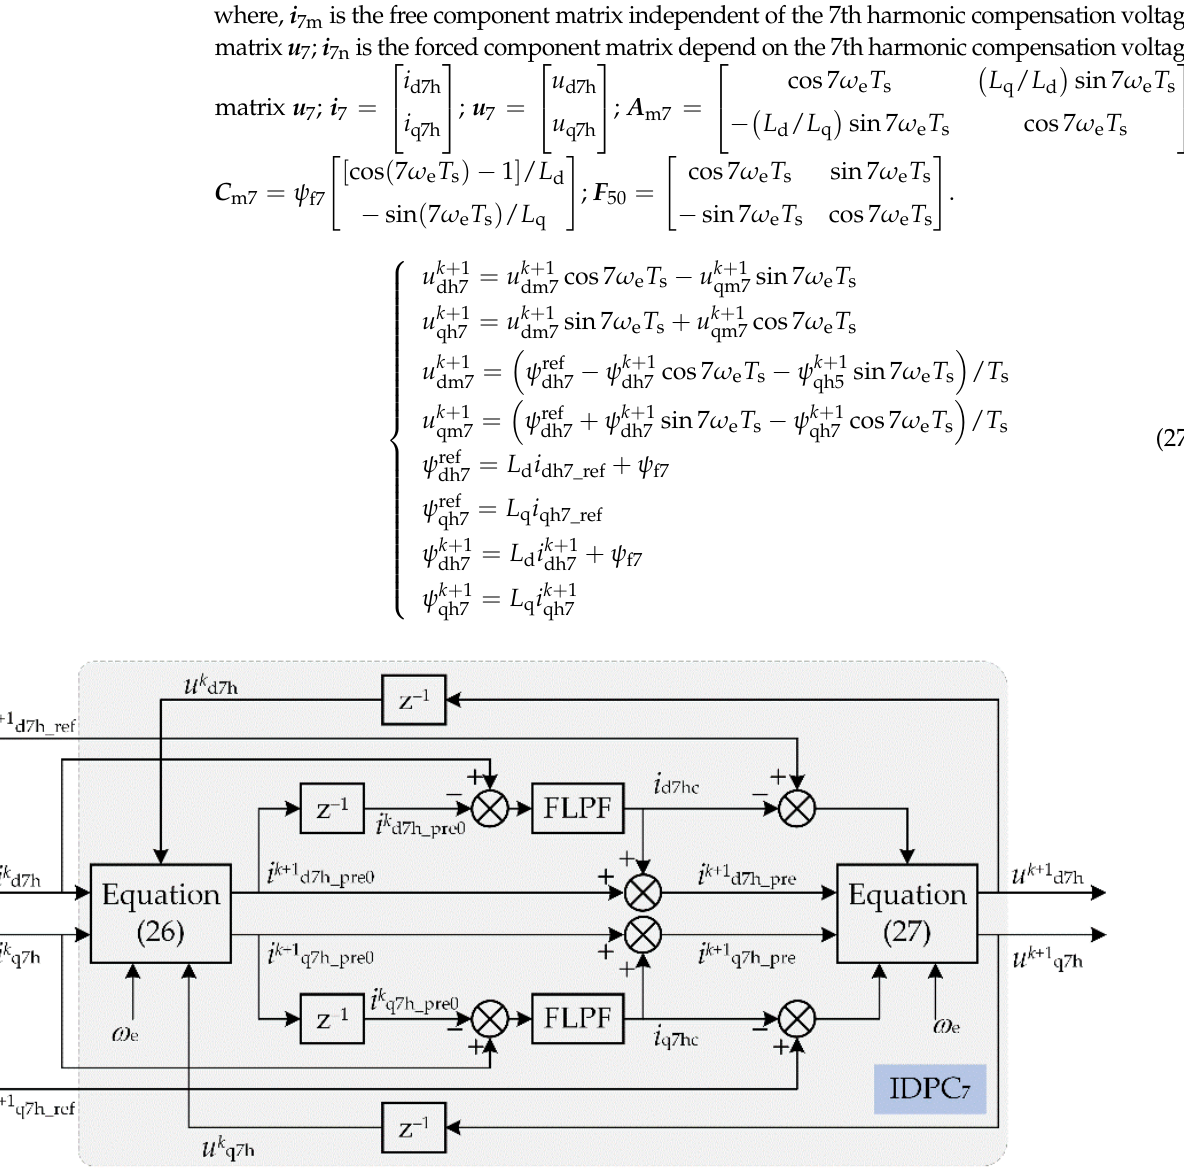
Figure 6. The block diagram of IDPC of the k th control cycle in the 7th synchronous rotating frame.